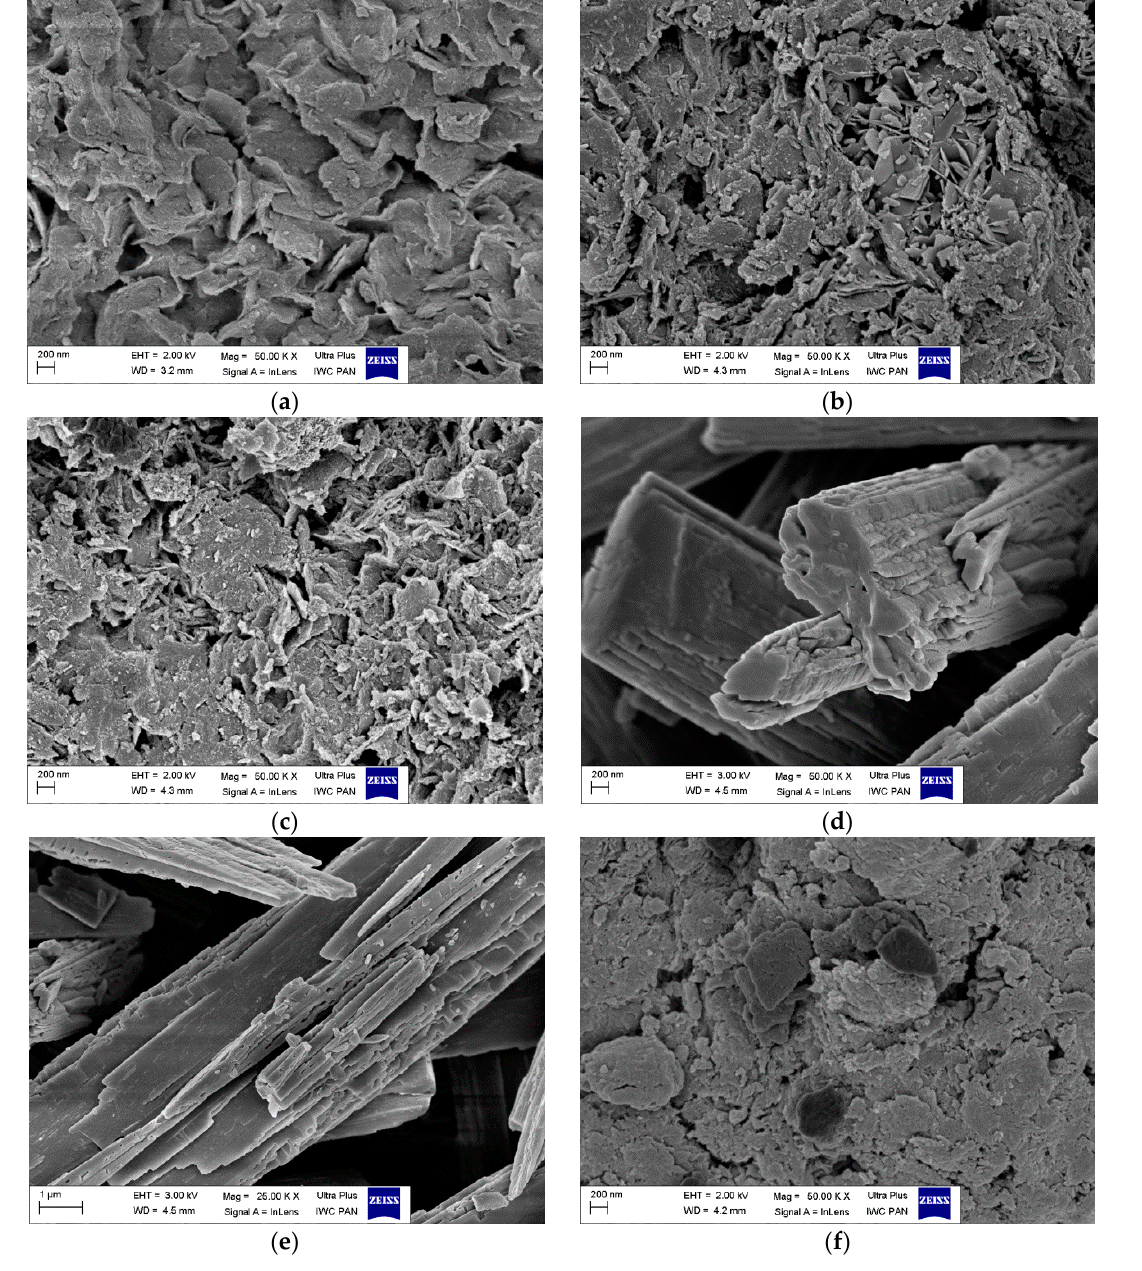
Figure 10. SEM images of LH ( a ); LH/Alizarin (15%) ( b ); LH/Alizarin (20%) ( c ); alizarin crystals ( d , e ); and Alizarin Crimson ( f ).